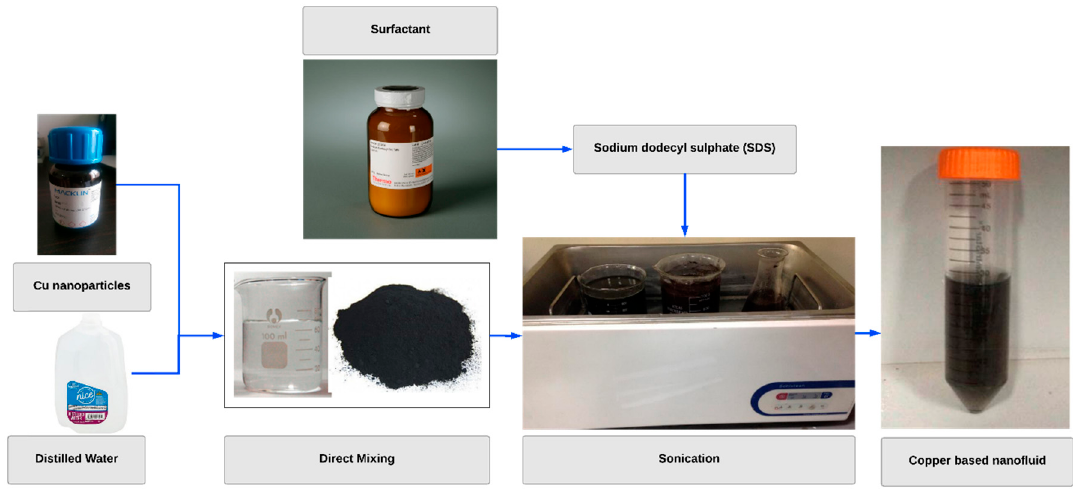
Figure 2. The preparation of copper based nanofluid.